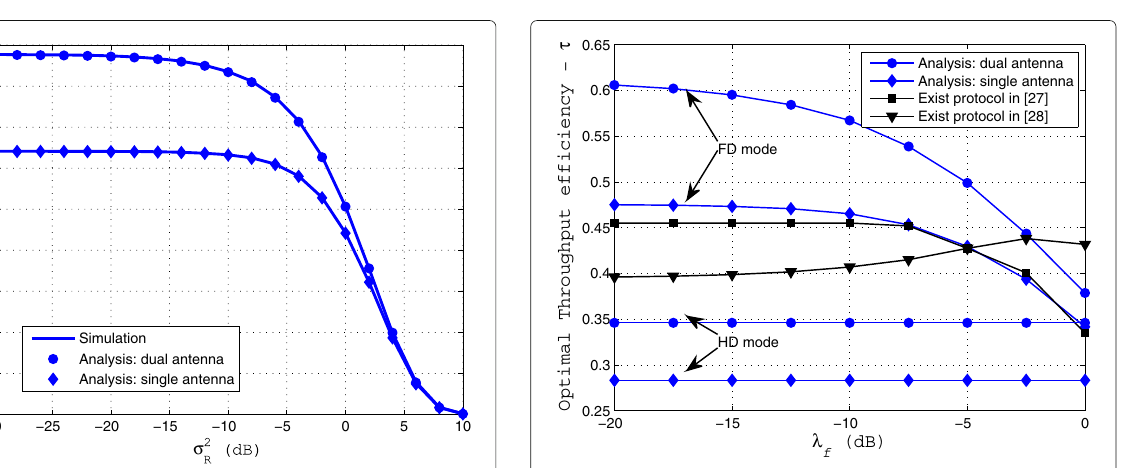
Fig. 7 Throughput efficiency versus σ 2 R with m f = 1